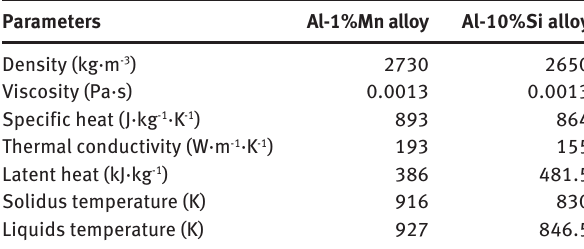
Table 2: Parameters of experimental